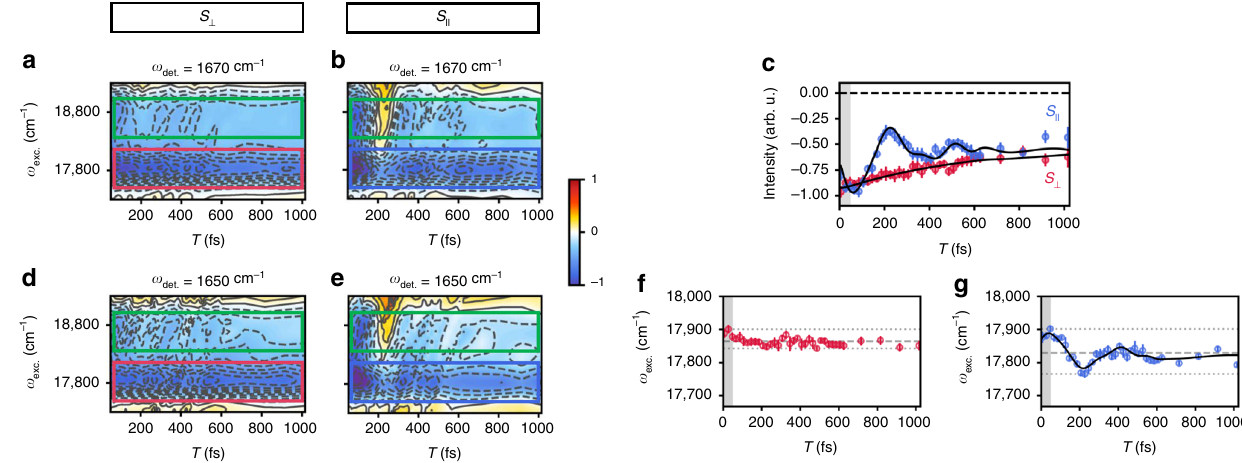
Fig. 3 Excited-state absorption dynamics along the excitation axis. a , b Perpendicular and parallel PA spectral evolution as a function of waiting time along the excitation axis at a fi xed detection frequency of 1670cm − 1 . Ground-state bleach features are positive (red) features and excited-state absorption features are negative (blue) features. The frequency region centered around 17,800 cm − 1 is boxed in red for the perpendicular PA component ( S ⊥ ) and blue for the parallel PA component ( S || ). Throughout, green boxes indicate the higher frequency region centered around 18,700cm − 1 . c Peak amplitude dynamics at a detection frequency of 1650 cm − 1 along 17,800cm − 1 (through the center of the corresponding boxed regions of the same color). Error bars indicate the estimated errors in the peak amplitude based on the standard deviation of the signal amplitude at each waiting time. The black lines indicate the fi ts of the peak amplitude dynamics (provided in Supplementary Table 1). The gray shaded region indicates the region where pulse overlap effects occur. d , e Same as described for a , b except at a detection frequency of 1650 cm − 1 . f , g Evolution of excited-state frequency distribution of the perpendicular and parallel PA spectra, respectively, at a detection frequency of 1670 cm − 1 . The error bars (1 σ intervals) indicate the uncertainty in the position of the peak maximum, determined by a Gaussian fi t of the peak in the range provided in the y -axis of the plot. The dashed gray line indicates the average center frequency, while dotted gray lines indicate the minimum and maximum frequencies. Again, the gray shaded region indicates the region where pulse overlap effects occur. The black line in g indicates the fi t of the evolution of the frequency distribution (provided in Supplementary Table